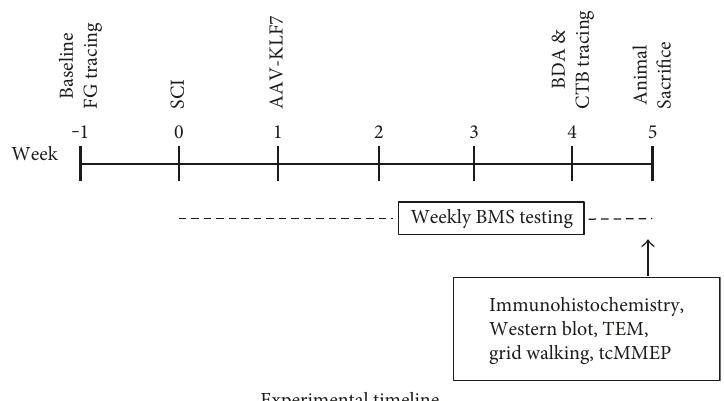
Figure 1: Experimental timeline. SCI: spinal cord injury; AAV: adeno-associated virus; CTB: cholera toxin B; FG: Fluoro-Gold; tcMMEP: transcranial magnetic motor-evoked potentials; BDA: biotinylated dextran amine; BMS: Basso Mouse Scale; TEM: transmission electron